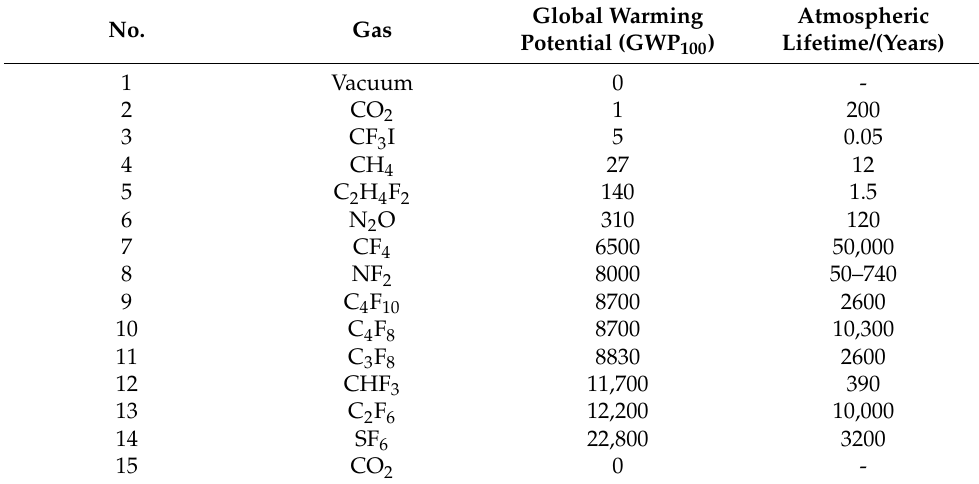
Table 1. Summary of alternatives to SF 6 gas [26–32].